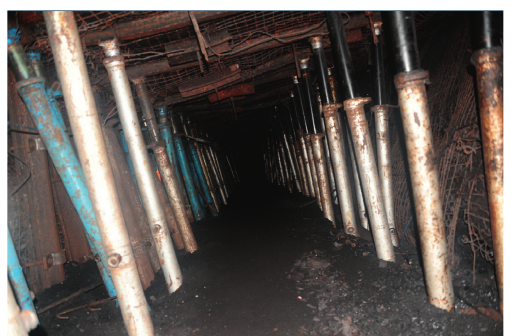
Figure 22: Field retaining